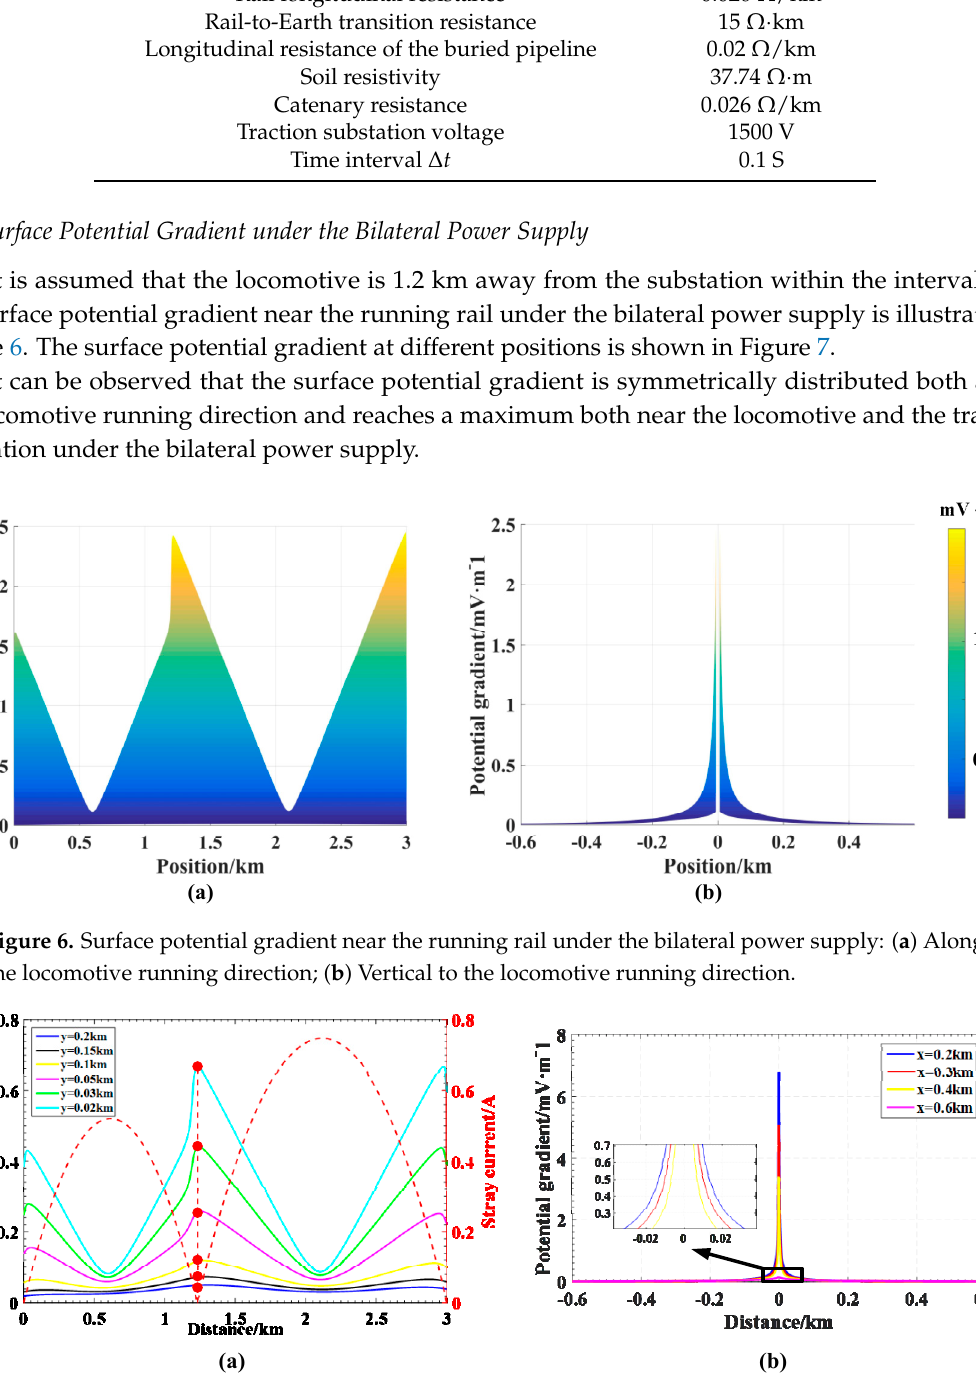
Figure 7. Surface potential gradient under the bilateral power supply: ( a ) Along the locomotive running direction; ( b ) Vertical to the locomotive running running direction; ( b ) Vertical to the locomotive running direction.